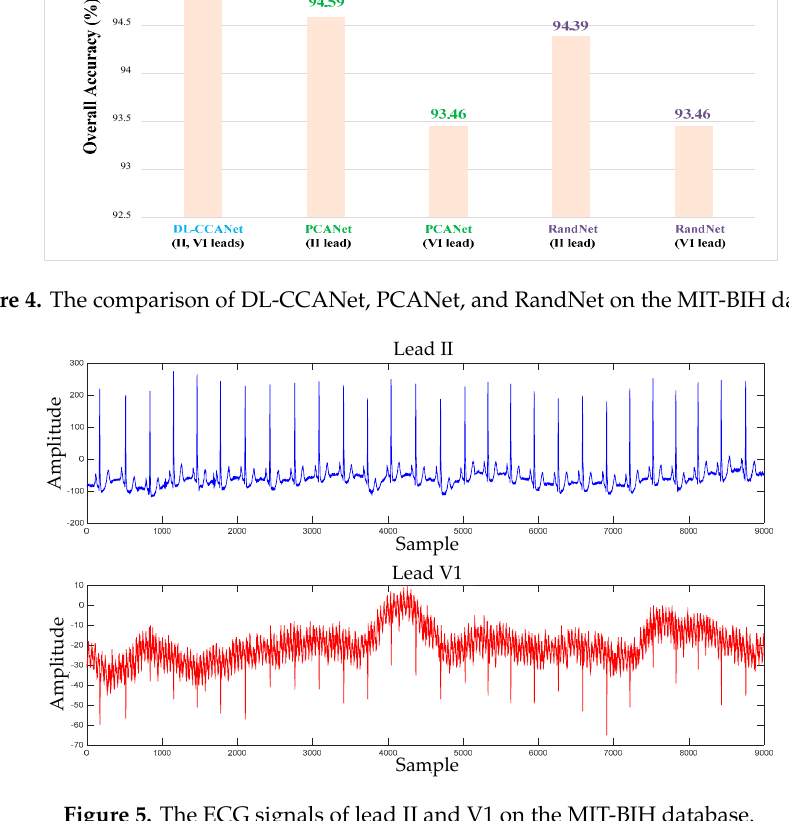
Figure 5. The ECG signals of lead II and V1 on the MIT-BIH database.